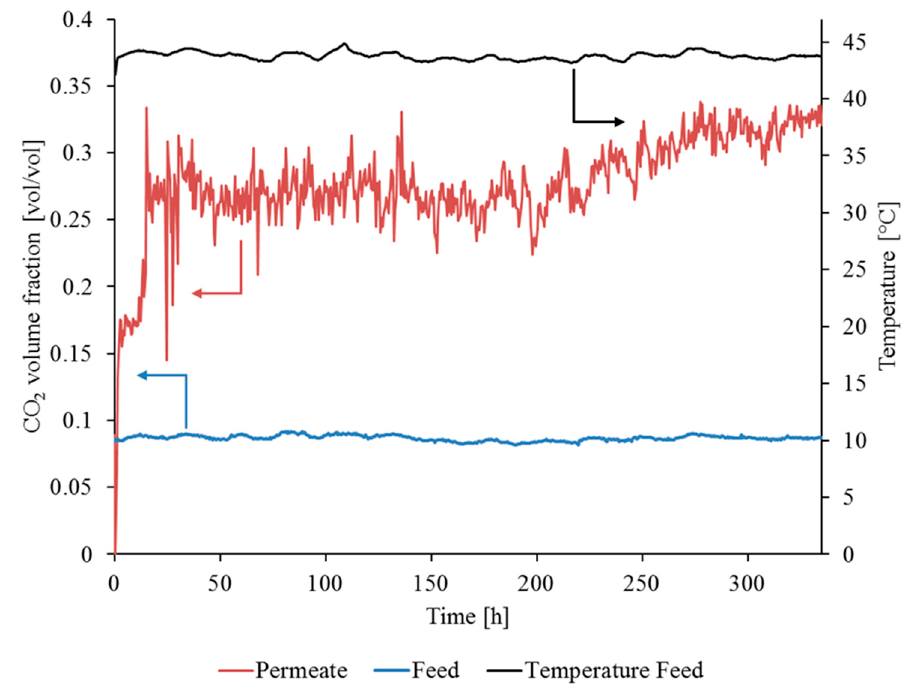
. , y , ϑ F , V N,F ~0.12 m 3 (STP)/h, , y (cid:2900),(cid:2887)(cid:2899) , ϑ F , V(cid:4662) (cid:2898),(cid:2890) ~0.12 m 3 (STP)/h, p (cid:2926) F,CO 2 P,CO 2 (cid:3118) (cid:3118)